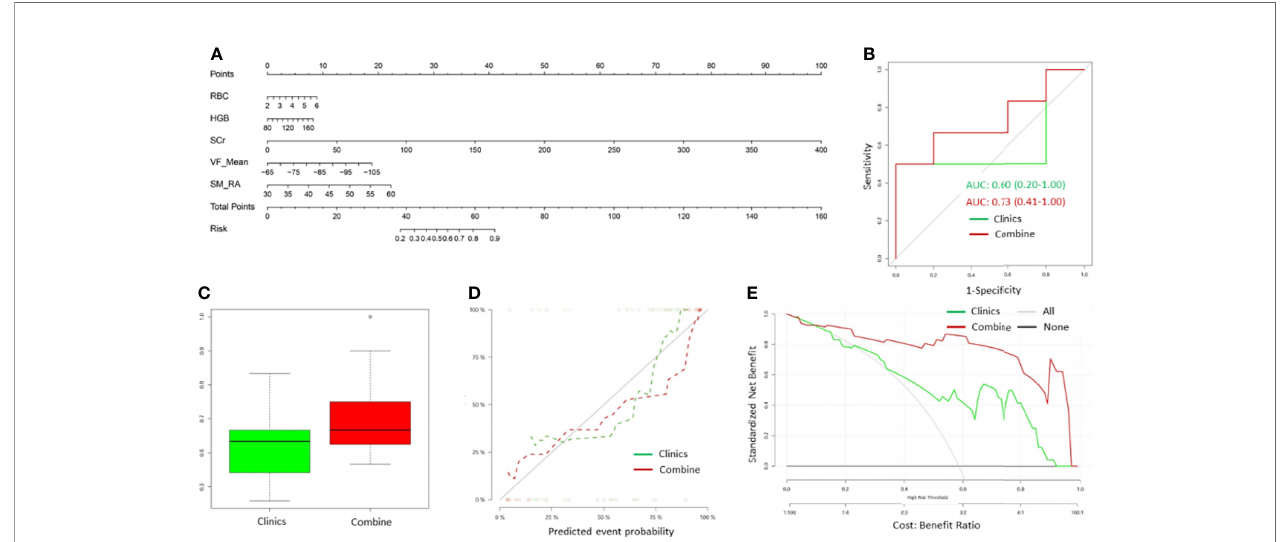
FIGURE 4 | The myosteatosis nomogram, ROC curve, calibration curve, and decision curve for predicting unfavorable outcomes in advanced-stager HCC patients treated with hepatic artery infusion chemotherapy (HAIC) combined with PD-1 immunotherapy. (A) Myosteatosis nomogram was constructed in the training cohort, including SM-RA, VFMean, Scr, HGB, and RBC. Risk represents the probability that the patient may obtain ORR after treatment. (B) An example of ROC curves for the independent training cohort for both clinical and combined models. (C) Box plots showing the AUCs for the clinical and combined models in multiple modeling processes. The green label indicates the clinical model, and the red indicates the combined model. (D) Calibration curves of the myosteatosis nomogram for clinical and combined models. (E) Decision curve analysis of the myosteatosis nomograms for the combined and clinical model alone. The Y-axis measures the net bene fi t. The green line represents the decision curve for the clinical model. The red line represents the decision curve for the combined model with the addition of CT myosteatosis features to the clinical model. The black line represents the assumption that no patients had the risk of transitioning to unfavorable outcomes, and the grey line represents all patients who would transition to unfavorable outcomes.